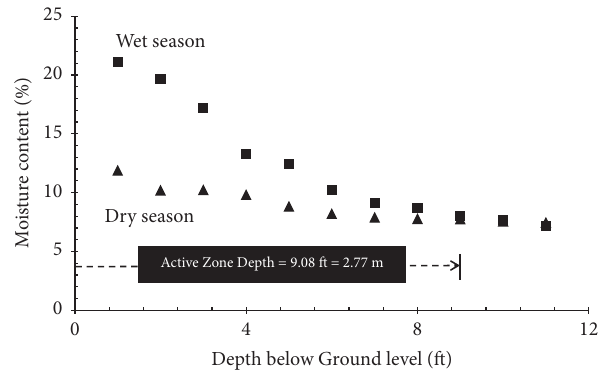
Figure 4: Active zone depth (AZD) of the expansive clay.